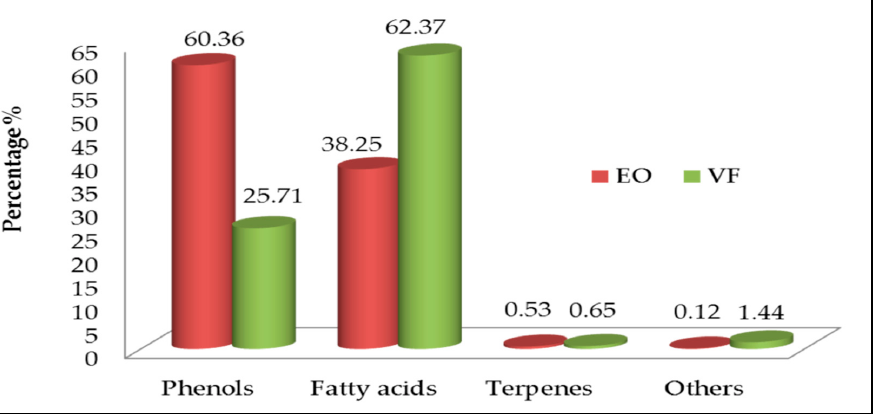
Figure 2. Percentage composition of the four chemical classes in VF and EO.